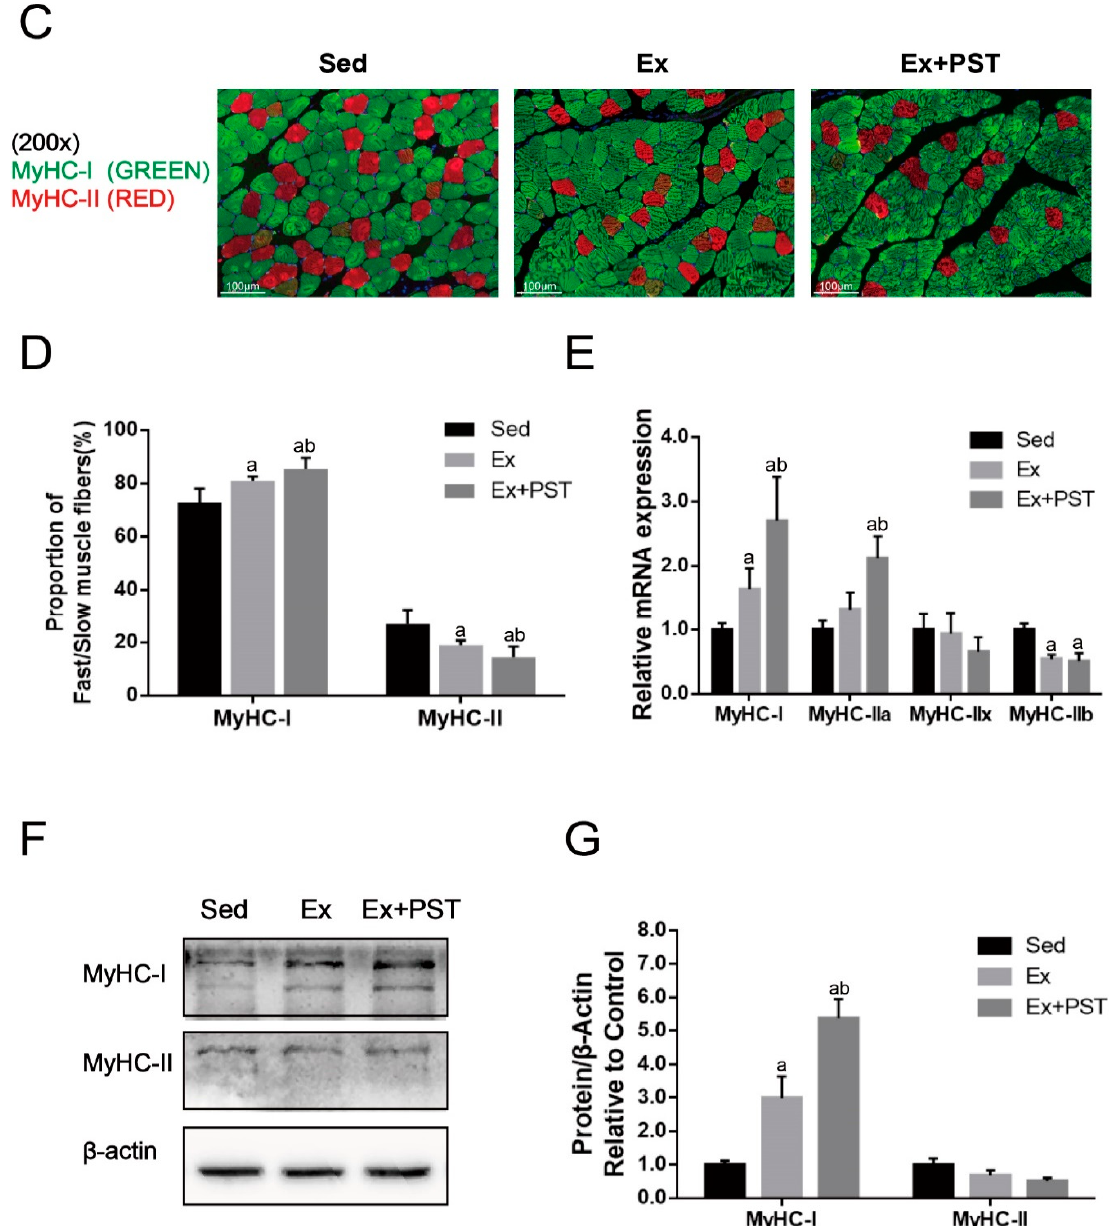
Figure 2. Effects of pterostilbene (PST) supplementation on the compositions of muscle fiber types in the soleus of exercise training rats. Soleus weight to body weight ratio ( A ) and a cross-sectional area (CSA) of soleus was measured ( B ). Changes in muscle fiber types of soleus were shown by immunofluorescent staining ( C , D ), real-time quantitative PCR ( E ) and Western blot ( F , G ). Scale bar, 100 μ m. Data are expressed as mean ± standard deviation (SD), a— p < 0.05 compared with the Sed group; b— p < 0.05 compared with the Ex group.